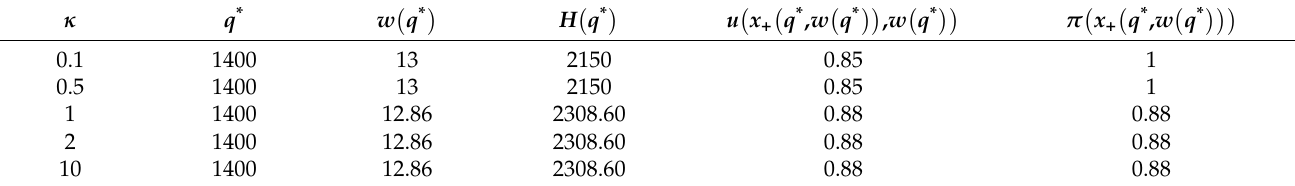
Table 3. Solutions of the proposed model with ϕ = 1 .